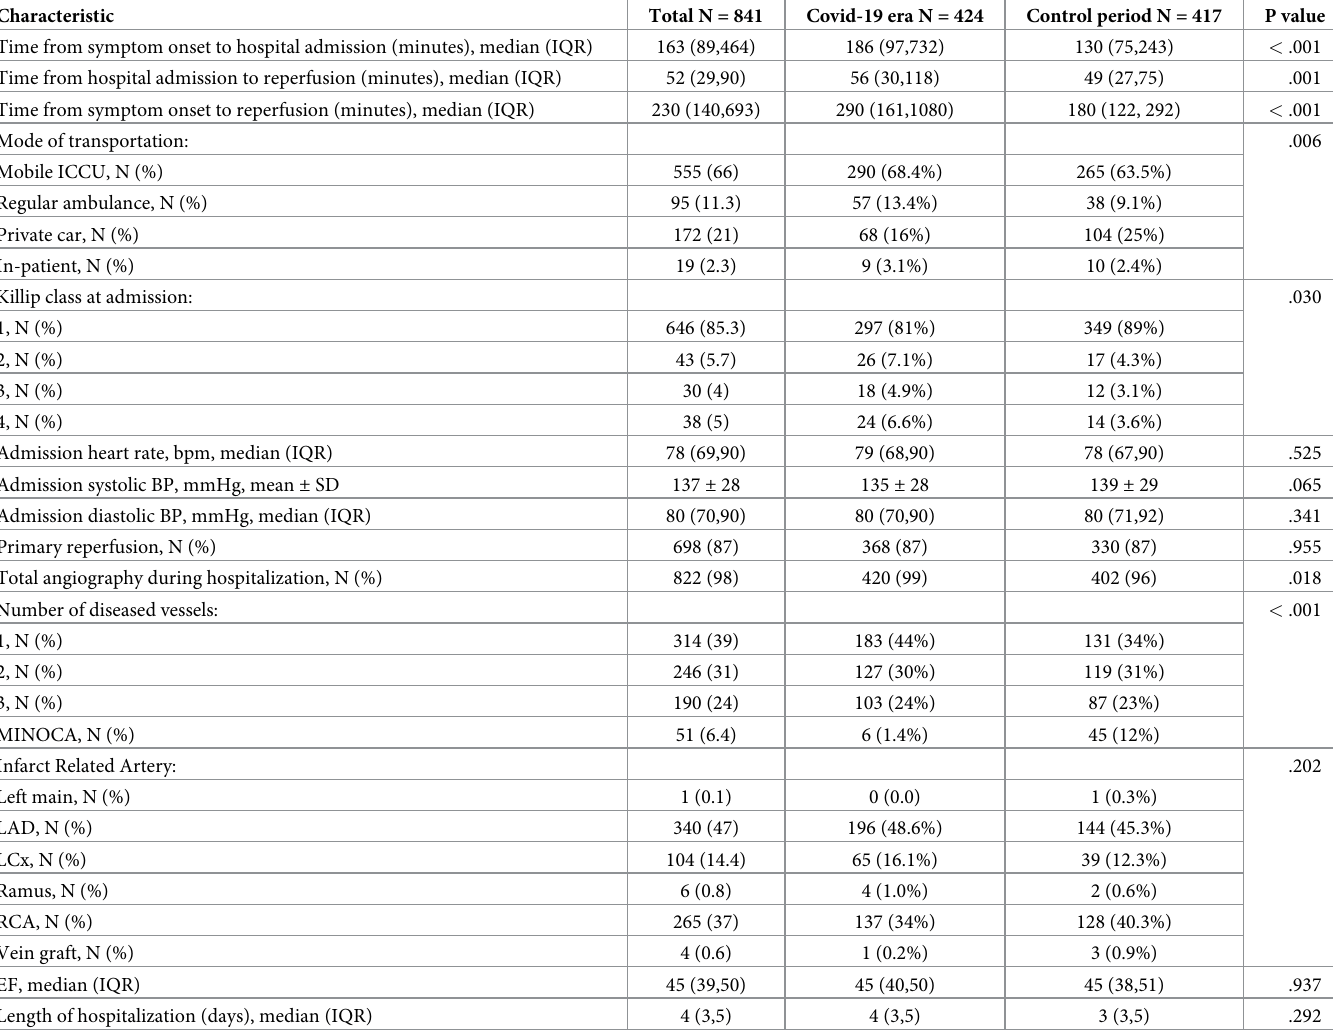
In-hospital outcomes were available for 99.4% of patients. As shown in Table 3, hospitalization during the Covid-19 period was independently associated with an increased risk for the pre- specified combined in-hospital outcome (OR 1.65, 95% CI 1.03–2.68, p value = .04) (Fig 5). When the secondary outcomes were analyzed using the multivariable logistic regression model, admissions during the Covid-19 era were associated with a higher incidence of sus- tained ventricular arrhythmias (OR 2.51, 95% CI 1.05–6.67, p-value = .05) and mechanical